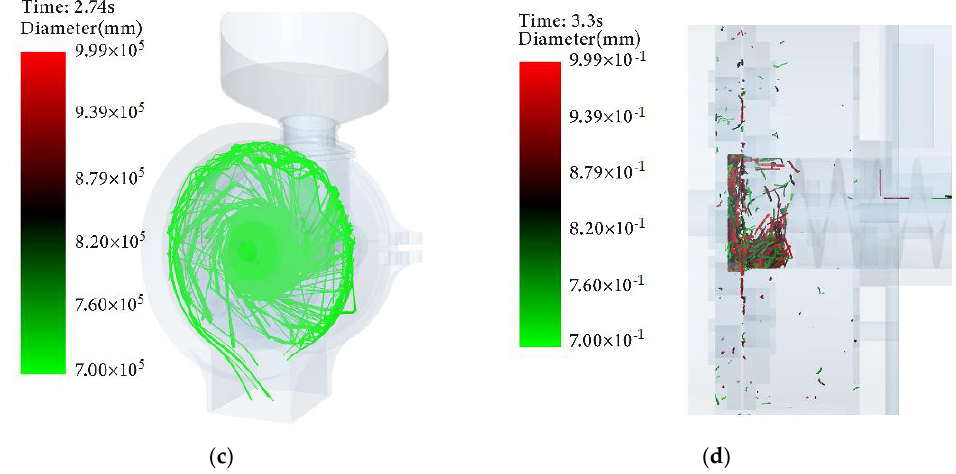
Figure 6. Particle distribution diagram of the straw crushing. ( a ) T = 2.9 s particle size distribution; ( b ) T = 3.3 s particle size distribution; ( c ) T = 2.74 s particle distribution streamline graph; ( d ) T = 3.3 s cross-section diagram of particle distribution.